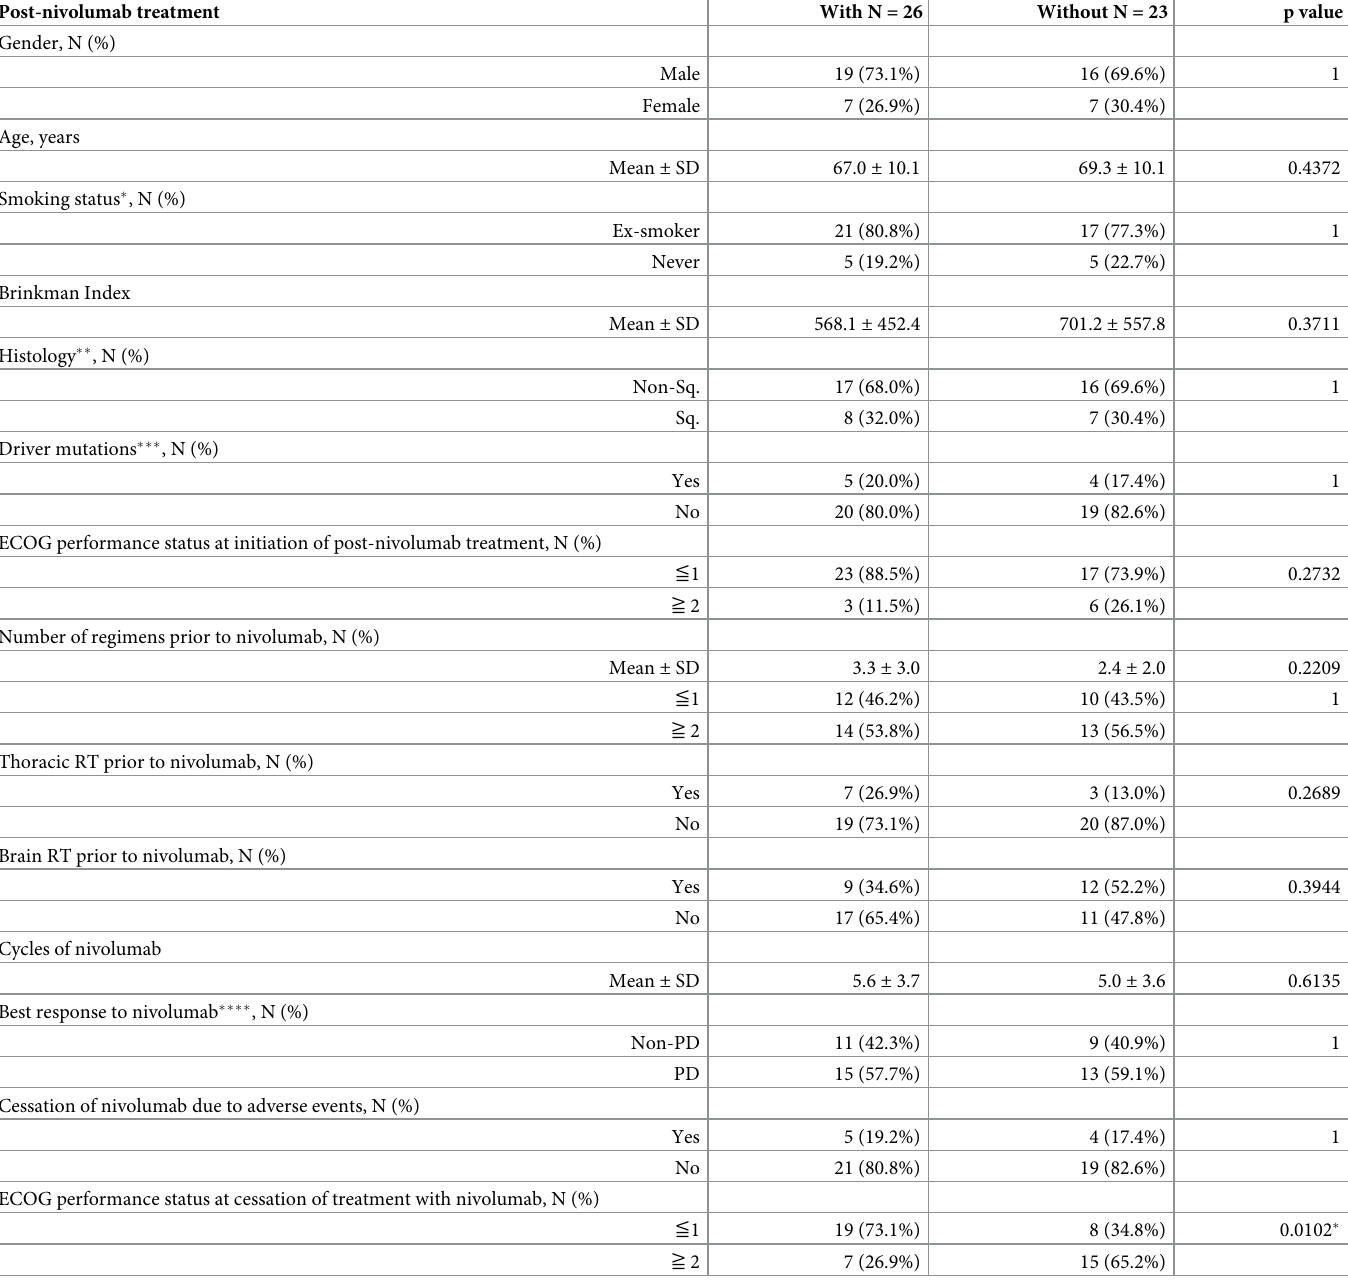
Table 4. Differences between patients with or without post-nivolumab